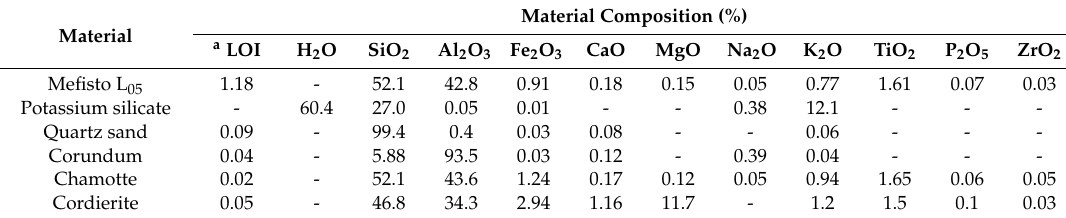
Table 1. Chemical composition (wt %) of raw materials.